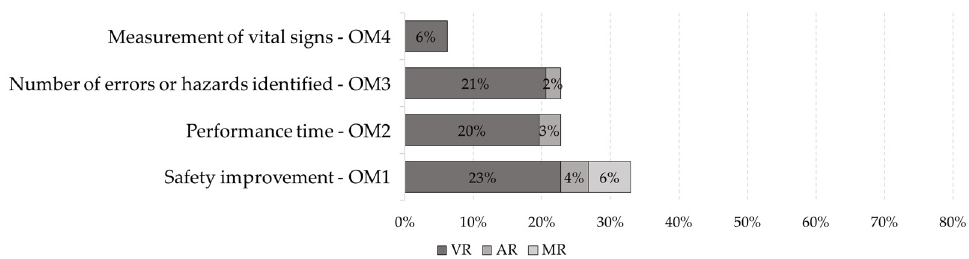
Figure 6. Types of evaluation belonging to the target objective method and number of correspond- ing XR tools. XR